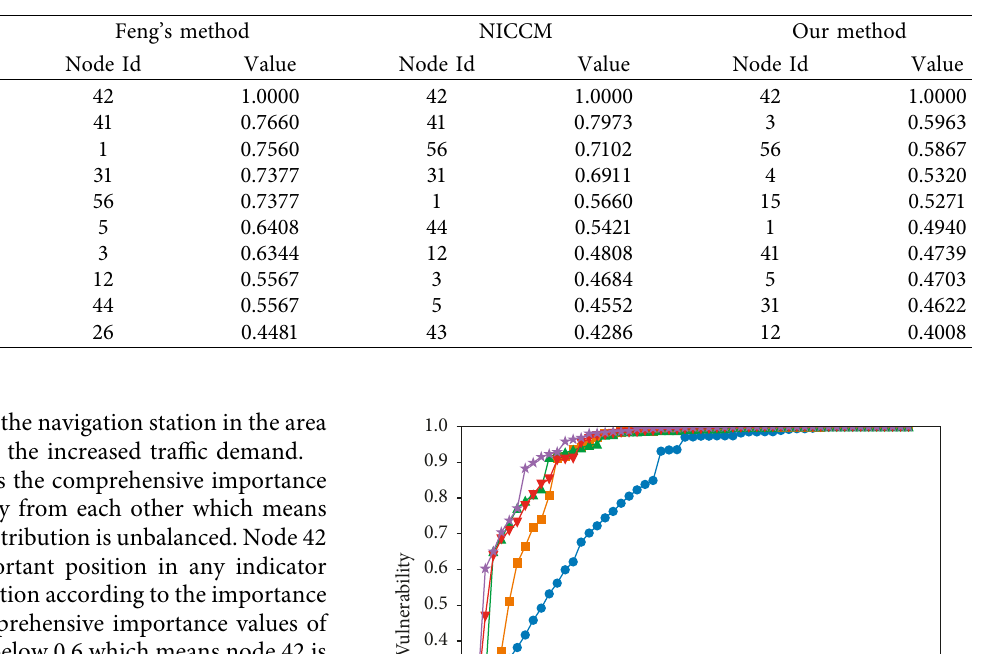
Table 5: Comparison of four different methods in node importance evaluation. Only the TOP TEN node values are listed in the table, accurate to 4 decimal places.